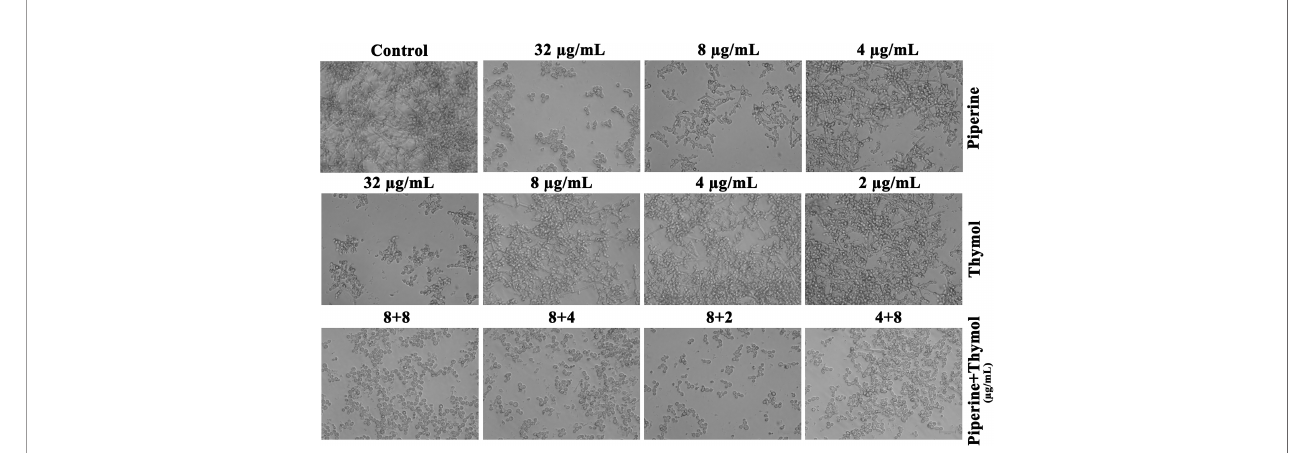
FIGURE 7 | Impediment of phenotypic switch between yeast to hyphal form. Extension of hyphae was completely arrested by piperine and thymol at individual MBIC as well the identi fi ed synergistic combinations. Few fi lamentous extensions were observed in C. albicans treated with individual phytochemicals at the concentration present in synergistic combinations.